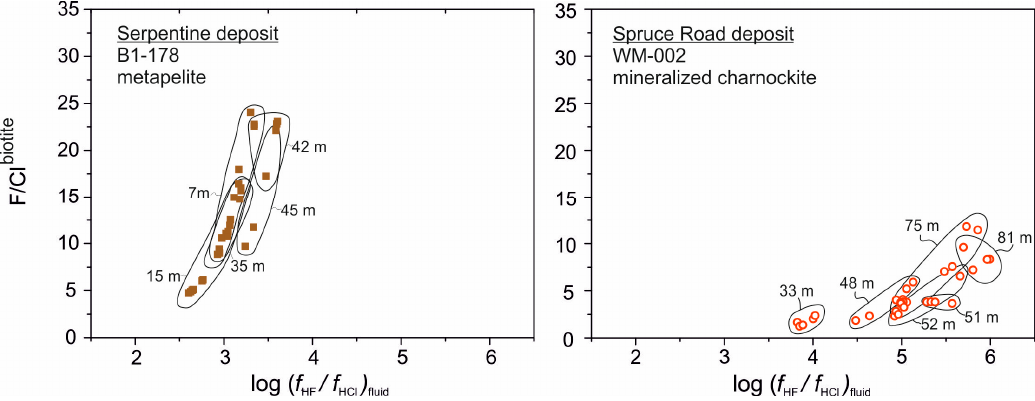
Figure 10. F/Cl in biotite (on the basis of apfu) versus log( f HF / f HCl ) fluid diagram for the B1-178 and WM-002 drill cores for the fluids that last equilibrated with the biotite. Note that with increasing depth (distance from the intrusion-footwall contact shown as meter values next to the delineated groups of data points), the log( f HF / f HCl ) fluid is increasing, i.e., the activity of chlorine is decreasing. Positive correlation between F/Cl biotite and log( f HF / f HCl ) proves that independent of the F-Cl avoidance effects, the F/Cl ratio in biotite is simply the function of the F/Cl ratio of the parent metamorphic